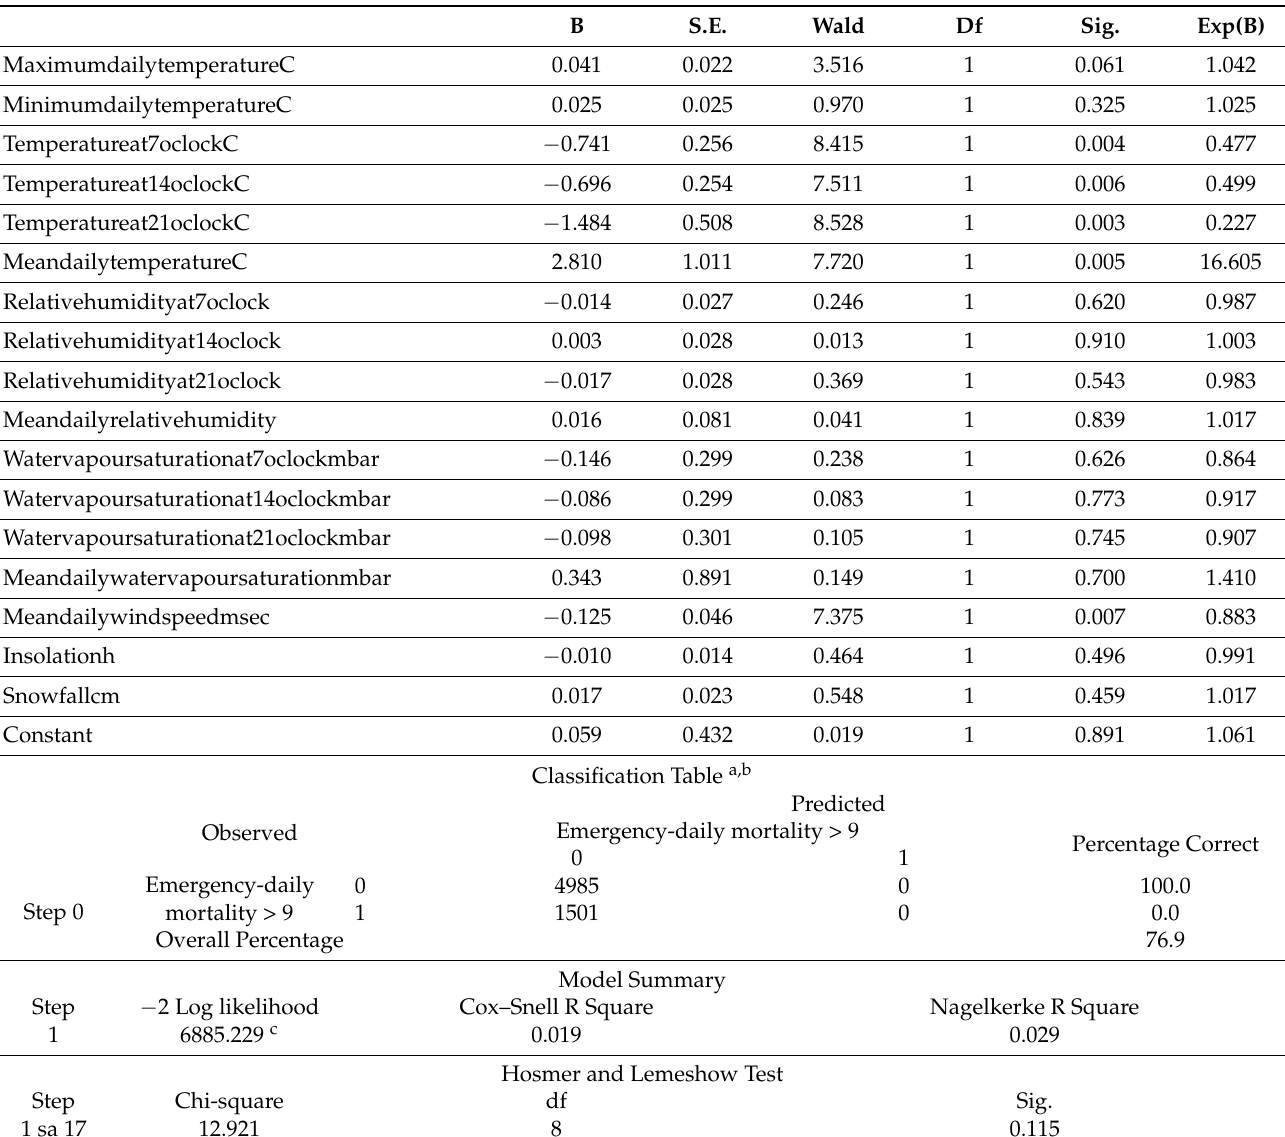
Table 6. Results of applied binary regression with the selected subset of 17